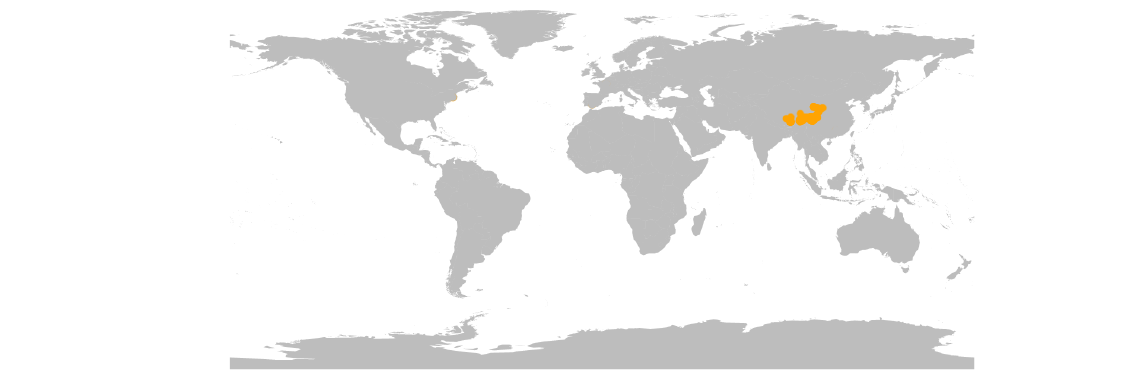
Fig. 27. Distribution of Malus toringoides (Rehder)